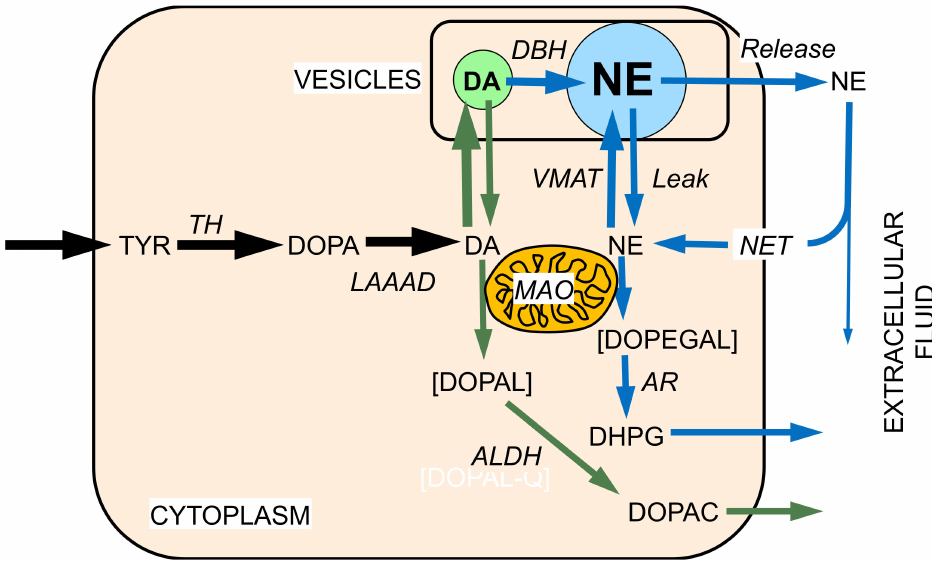
Figure 3. Norepinephrine synthesis, storage, reuptake, and metabolism. In noradrenergic neu- rons, dopamine (DA) is produced in the cytoplasm as in dopaminergic neurons. Dopamine-beta- hydroxylase (DBH) in the vesicles catalyzes the production of norepinephrine (NE) from DA. As for DA, cytoplasmic NE is subject to oxidative deamination catalyzed by monoamine oxidase-A (MAO- A) in the outer mitochondrial membrane, to form 3,4-dihydroxyphenylglycolaldehyde (DOPEGAL). It should be noted that NE is a poorer substrate than DA for MAO of either isoform. DOPEGAL is converted to 3,4-dihydroxyphenylglycol (DHPG) via aldehyde/aldose reductase (AR). A minor pathway (not shown) involves conversion of DOPEGAL to dihydroxymandelic acid via aldehyde dehydrogenase (ALDH). As for DA, most of vesicular NE released by exocytosis is taken back up into the cytoplasm via a cell membrane transporter—the cell membrane norepinephrine transporter (NET) for NE (although DA is a better substrate than NE for uptake via the NET). Theoretically, NE can be oxidized spontaneously to NE quinone and downstream oxidation products. Other abbrevia- tions: LAAAD = L-aromatic-amino-acid decarboxylase; TH = tyrosine hydroxylase; TYR = tyrosine; VMAT = vesicular monoamine